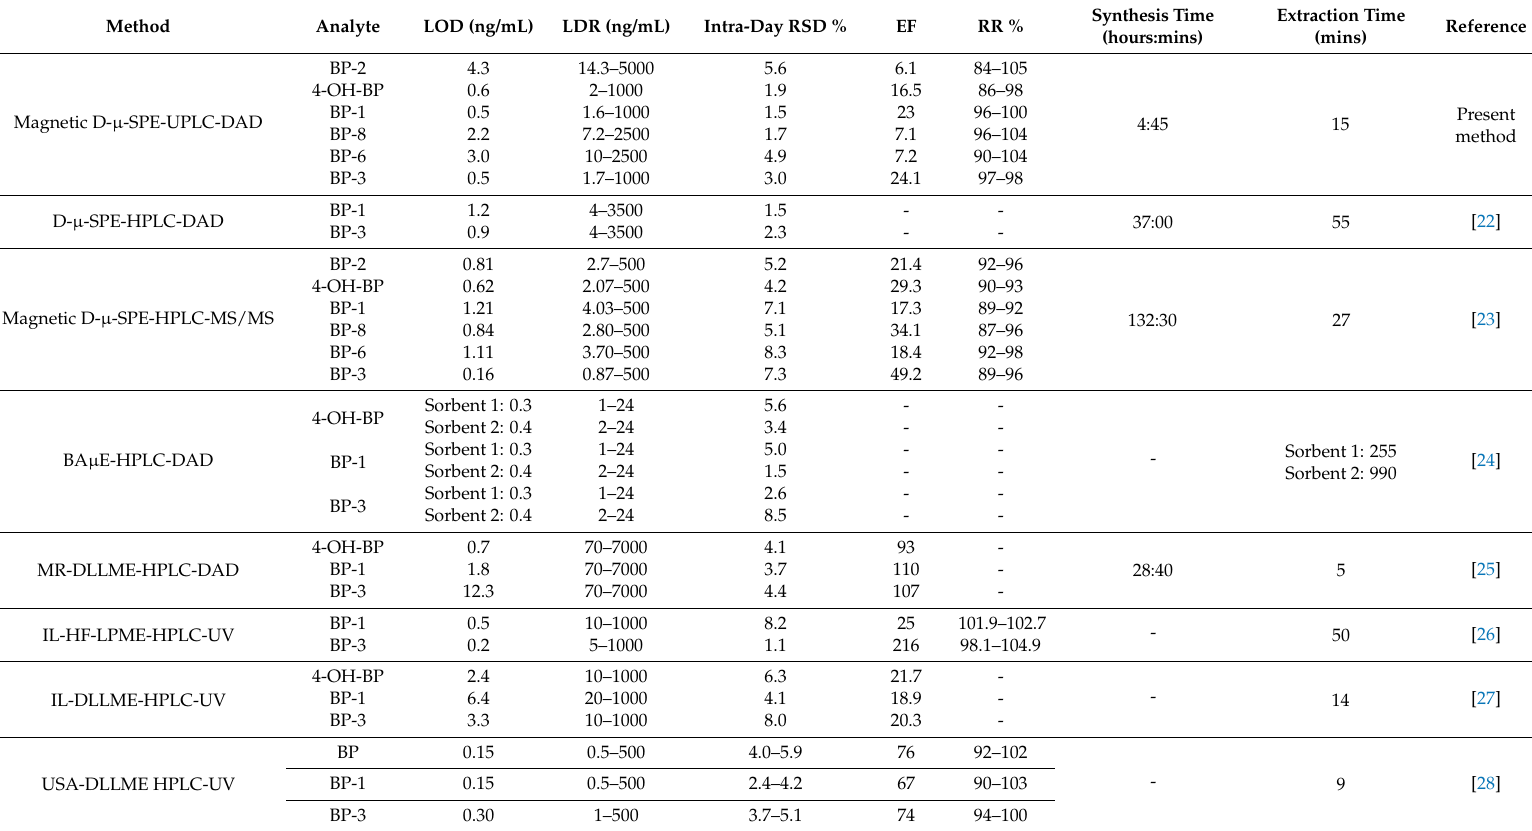
Table 4. A comparison of the proposed method with other reported